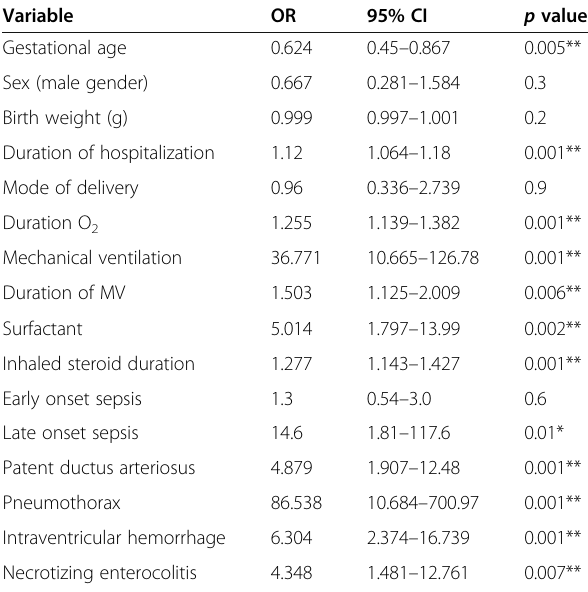
Table 6 Univariate analysis of clinical variables influencing the risk of